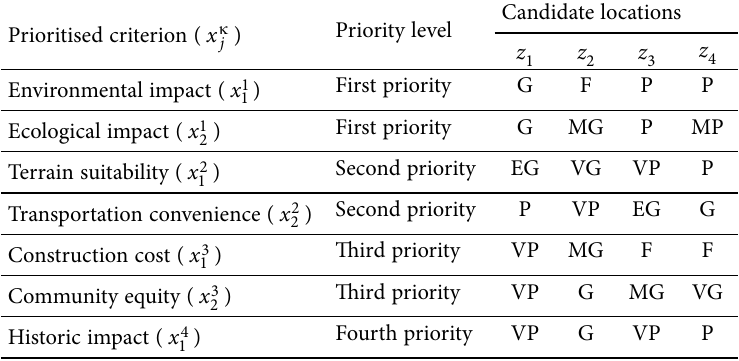
Table 3. Prioritisation relationships and linguistic ratings Prioritised criterion ( κ j x